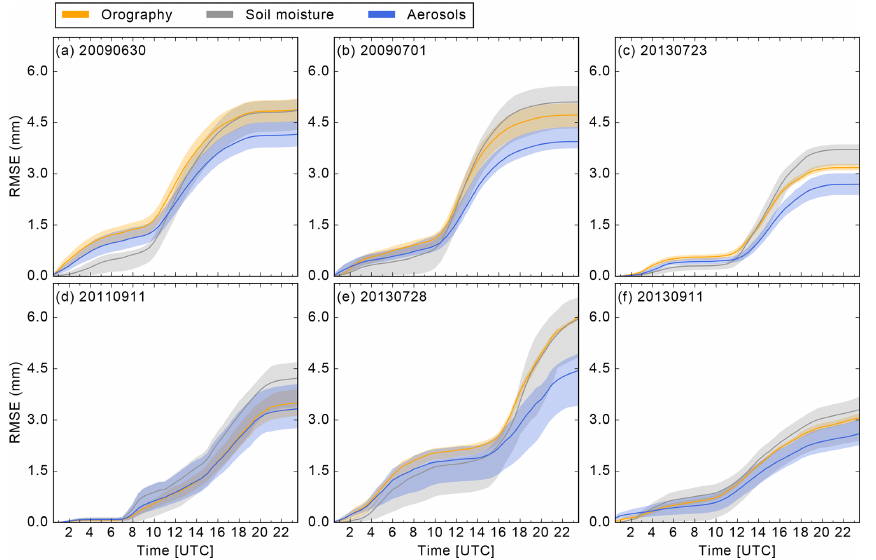
Figure 6. Root mean square error (RMSE) for precipitation of the sensitivity runs compared to the reference run. Thick lines indicate the mean and color-coded areas the range between the minimum and maximum